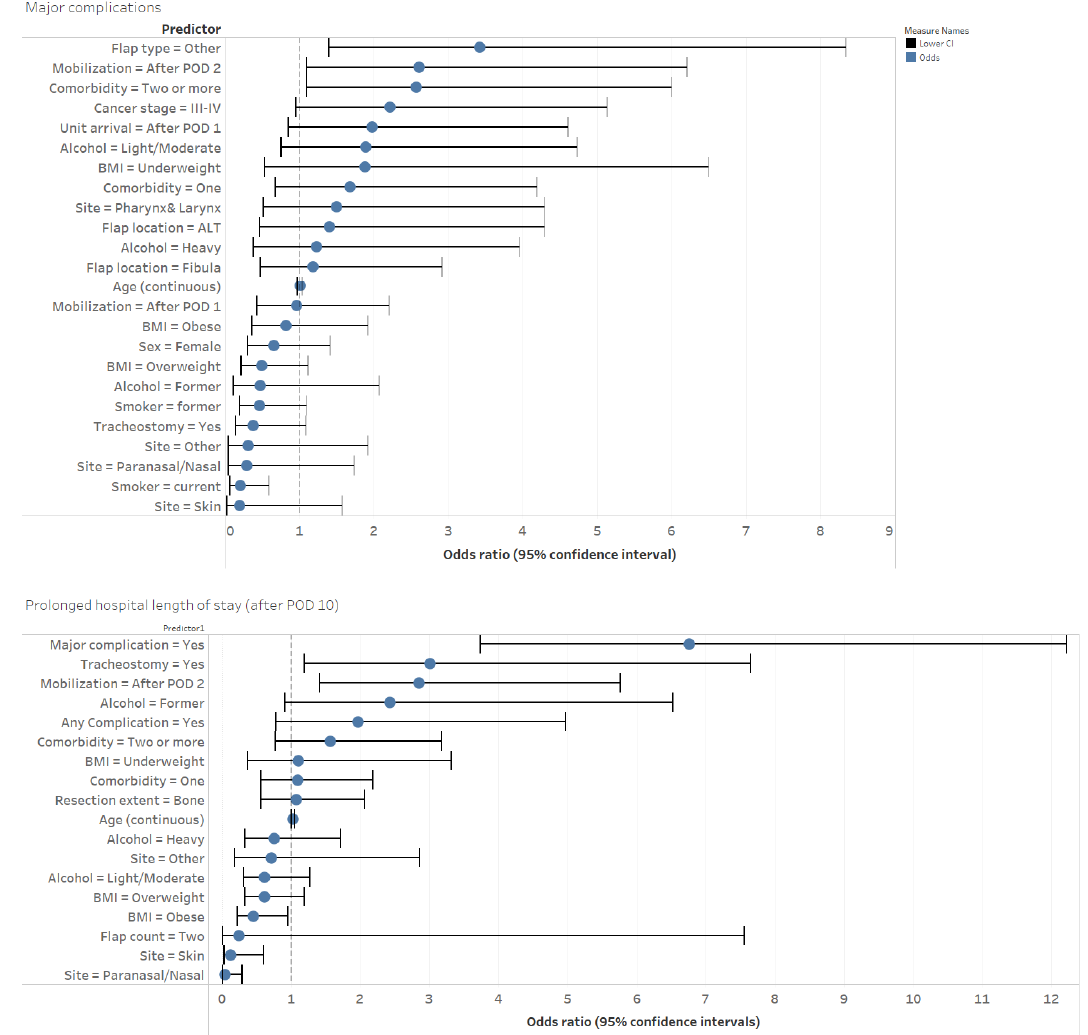
Figure 1. A visual representation of the odds ratios and 95% confidence intervals for the multivariable logistic regression models of major postoperative complications (top panel) and a prolonged LOS (bottom panel). BMI = body mass index. POD = postoperative date. Flap count and resection extent were removed from this visualization due to wide confidence intervals (Table S3). The reference levels for the categorical variables were: Alcohol status = never; BMI = healthy range; sex = male; smoking status = never; alcohol status = never; comorbidity = none; primary site = Oral Cavity; Cancer stage = I–II; flap count = one; resection extent = soft tissue only; flap donor site = radial forearm; mobilization = POD 0–1 (within 24 h) and POD 0–2 (within 48